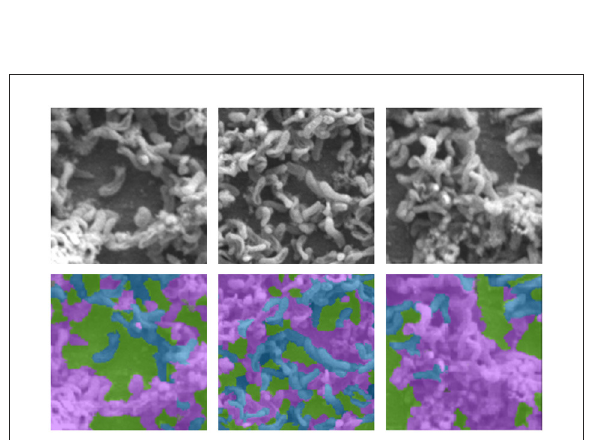
FIGURE3 Sample SEM images (first row) with their respective annotations (second row), where Byproduct , Cells , and Surface indicates by the colors pink, blue, and green,